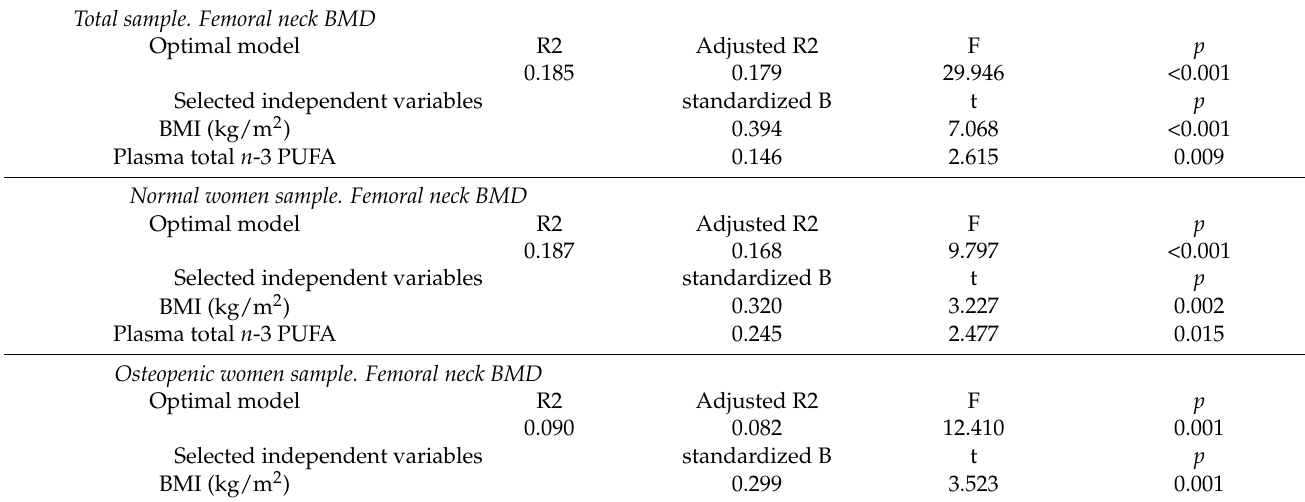
Table 11. Multiple linear regression analysis for the BMD at the femoral